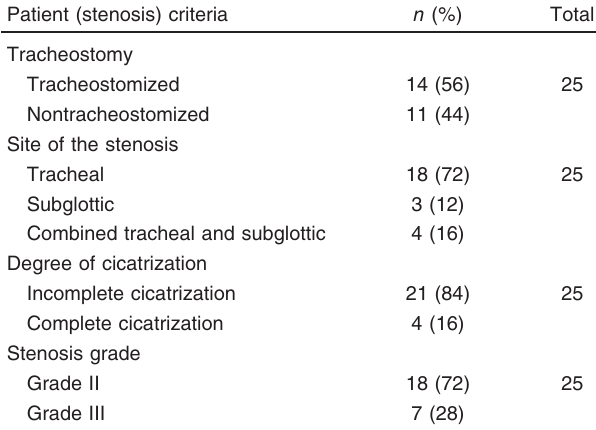
Patient (stenosis)